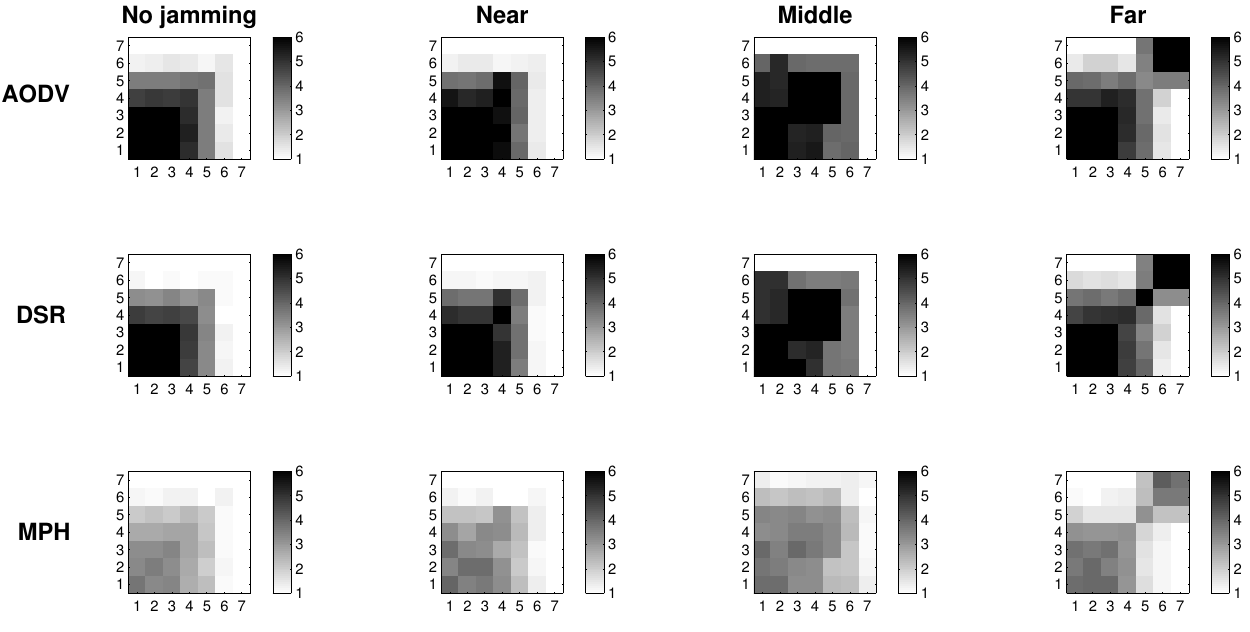
Figure 11. 2D representation of energy for the no jamming and reactive cases when the jammer node is near to, in the middle of and far from the